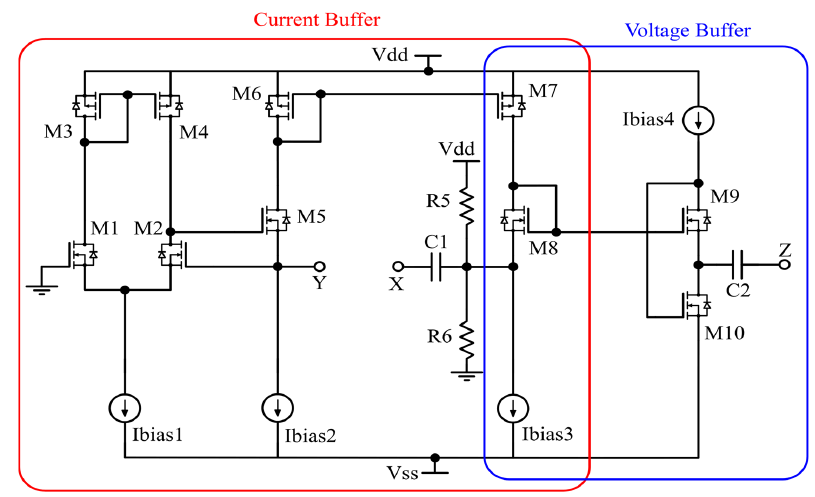
Figure 3. Simplified schematic of the proposed discrete VCII.